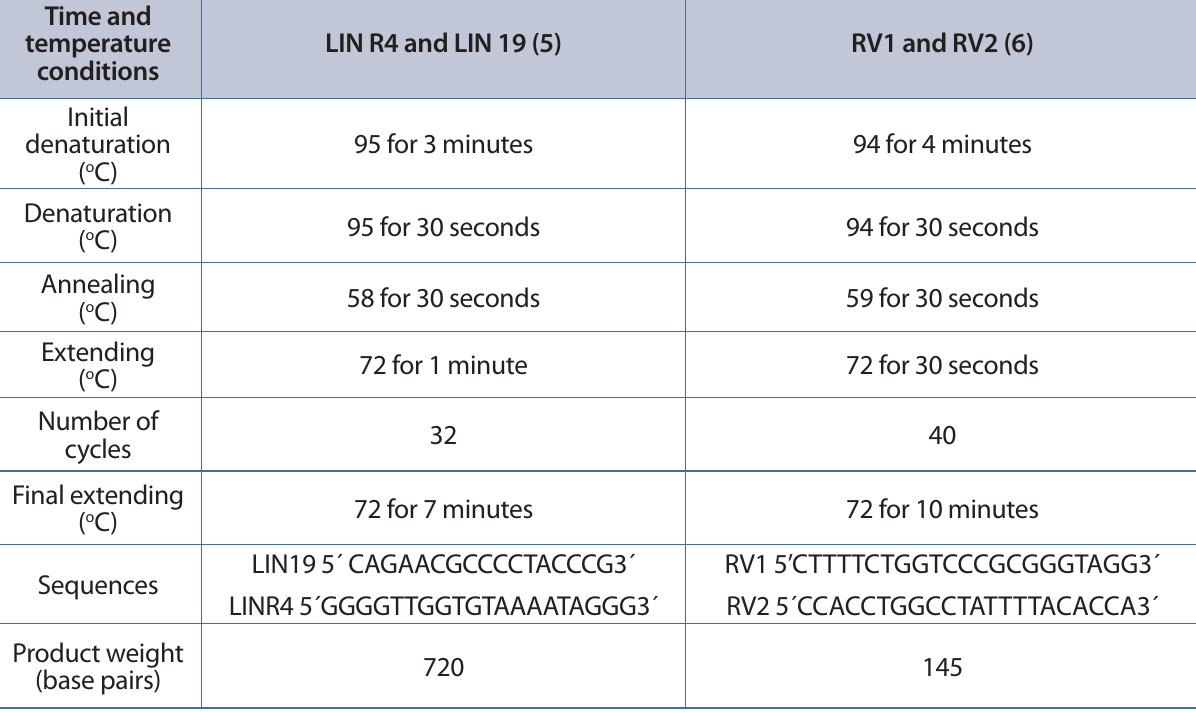
Table 1. Thermocycler conditions for amplification and characterization of the primers Time and temperature